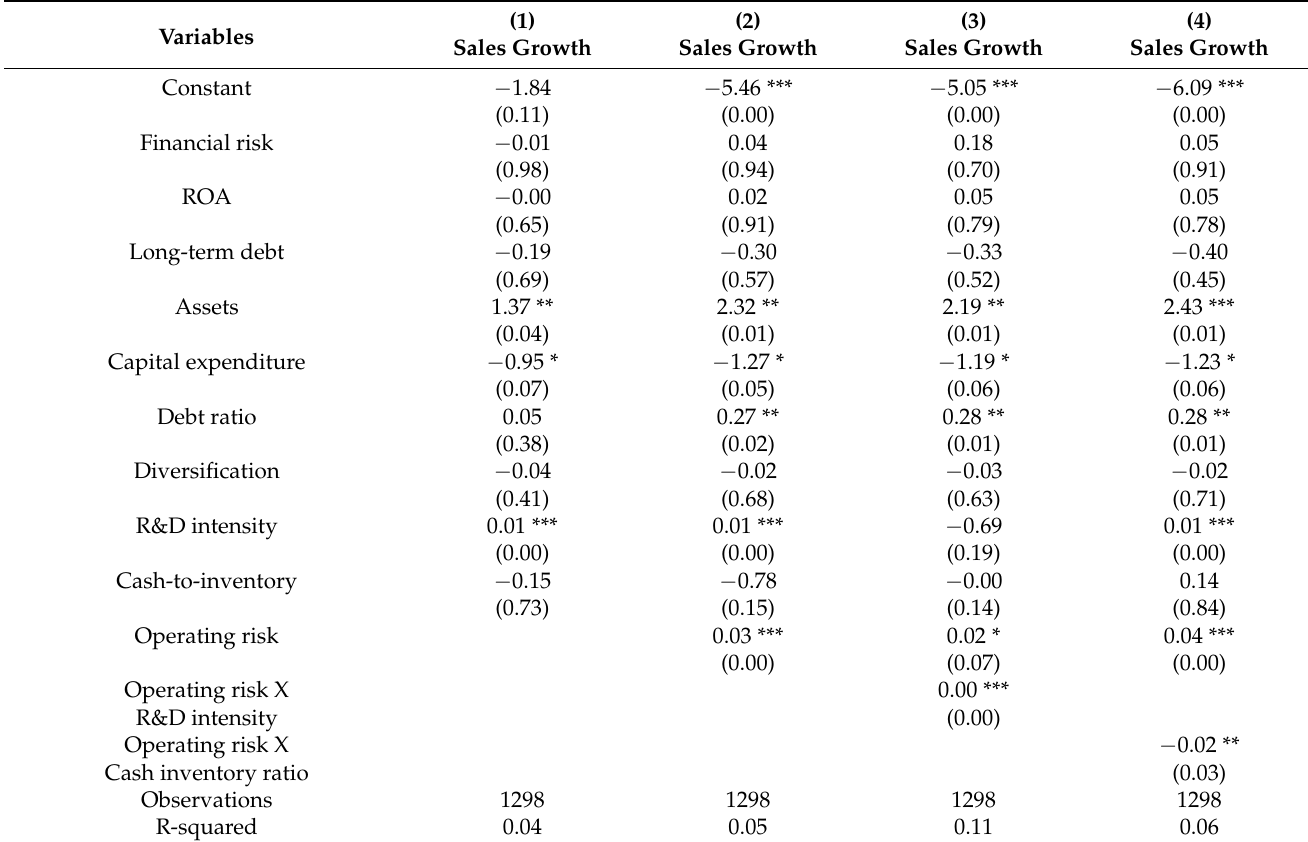
Table 2. OLS regression: Sales growth in